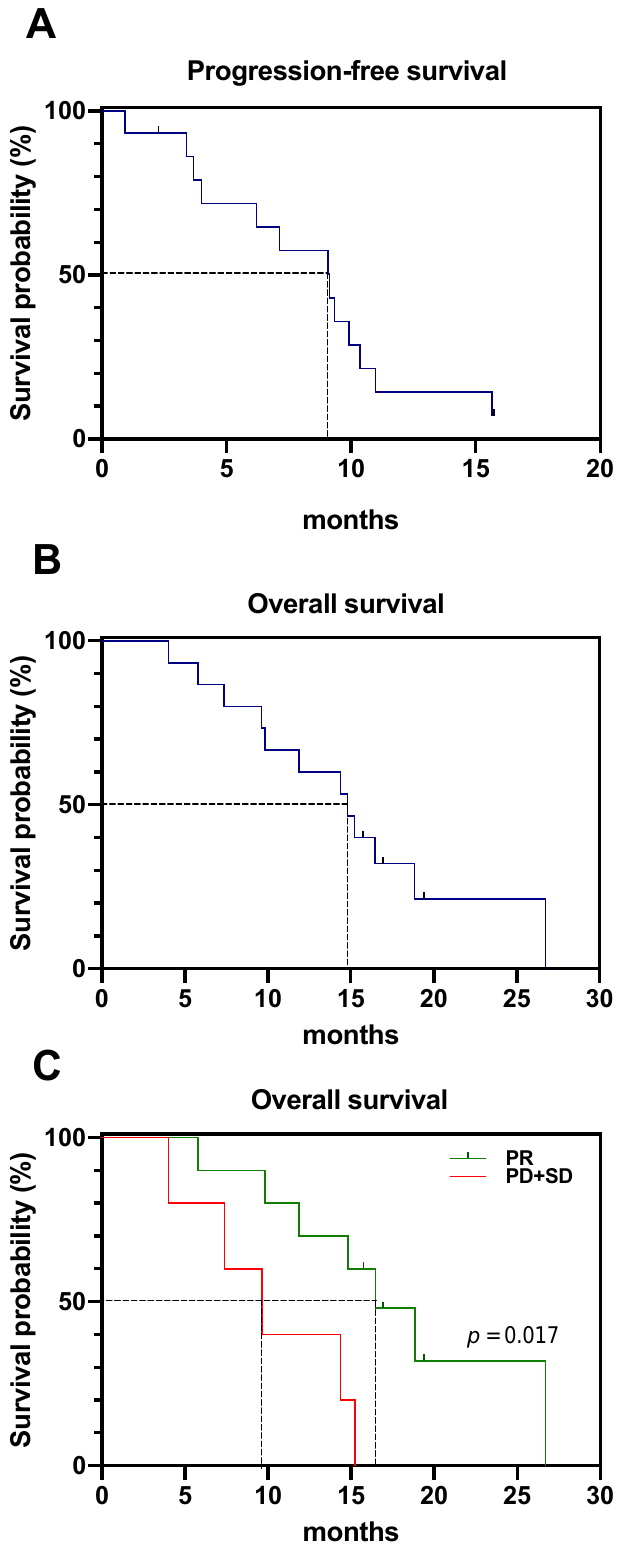
Figure 3. Kaplan–Meier curves of ( A ): PSA-based progression-free survival of the entire cohort; ( B ): overall survival of the entire cohort; ( C ): overall survival stratified by molecular imaging response (green: partial remission (PR); red: progressive disease (PD) or stable disease